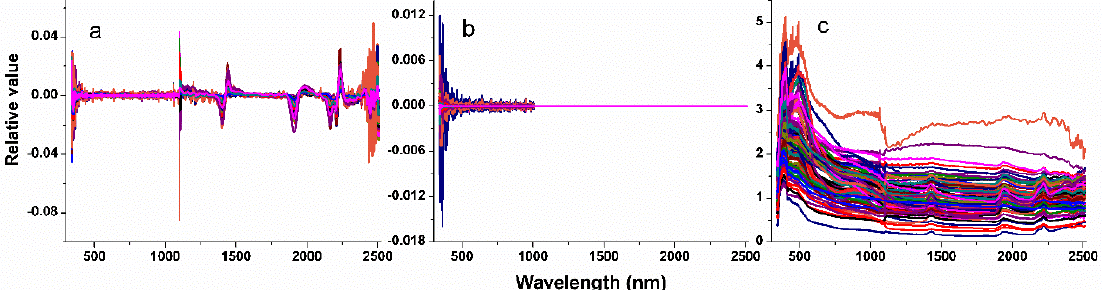
Figure 4. Transformed spectral indices of soil samples: ( a ) First derivative spectral curves; ( b ) Second derivative spectral curves; and ( c ) Reciprocal logarithmic spectral curves.